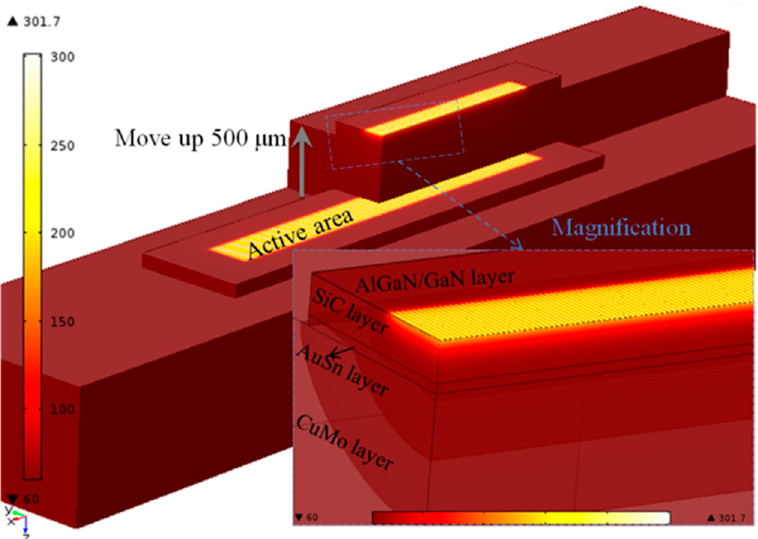
Figure 3. Temperature distribution and isothermal surfaces of device.